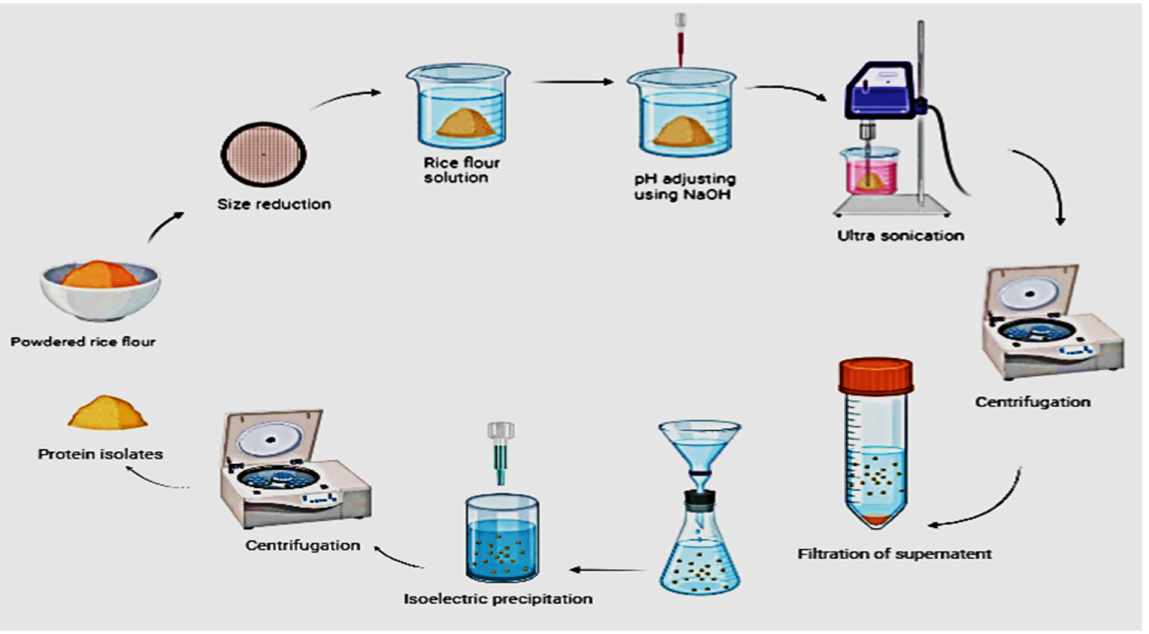
Figure 2. Schematic representation of ultrasonic-assisted alkali extraction of rice